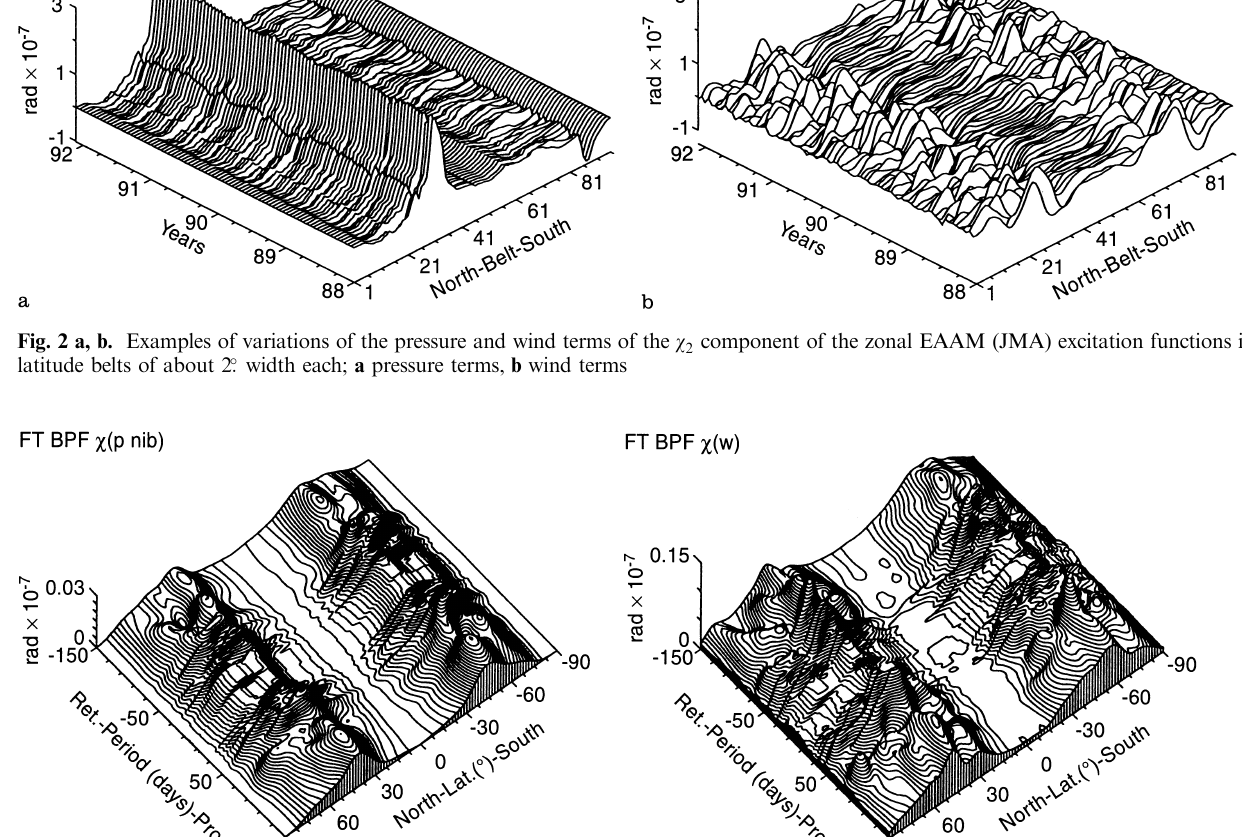
Fig. 3 a, b. Latitude-variable FT BPF amplitude spectrum of the complex-valued a pressure and b wind terms of the (cid:118) component of the zonal EAAM (JMA) excitation functions; + denotes the prograde oscillations, ) denotes the retrograde